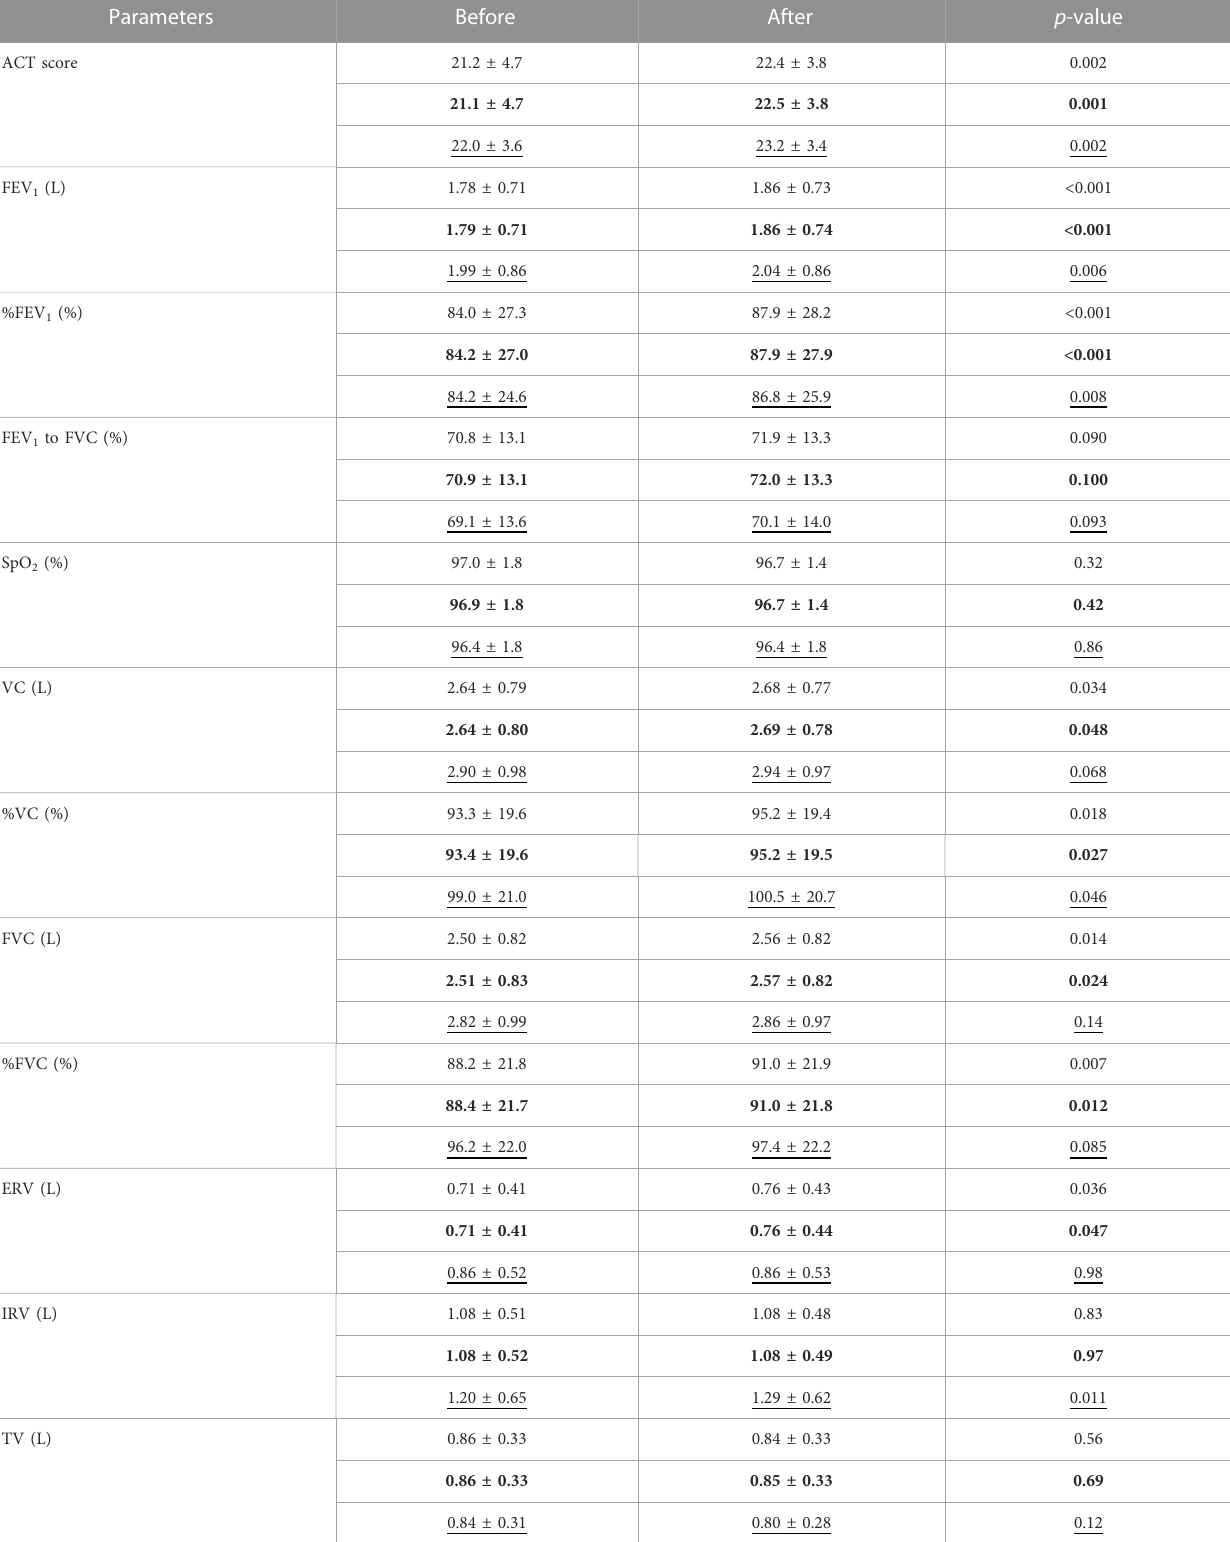
TABLE 2 Changes in other parameters by the (switching) use of FF/UMEC/VI 200/62.5/25 μ g and comparison of the impact of rollout between FF/UMEC/VI 200/ 62.5/25 μ g and FF/VI 200/25 μ g. Parameters